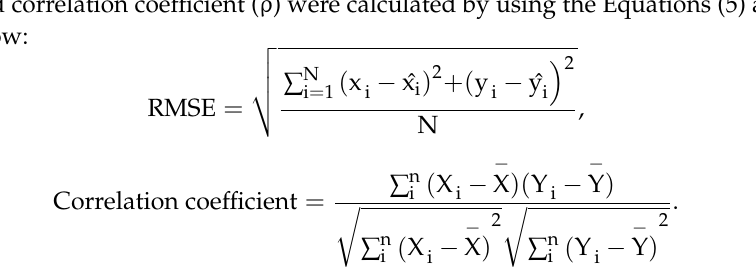
Figure 7. COP extraction process using I-TCPs.